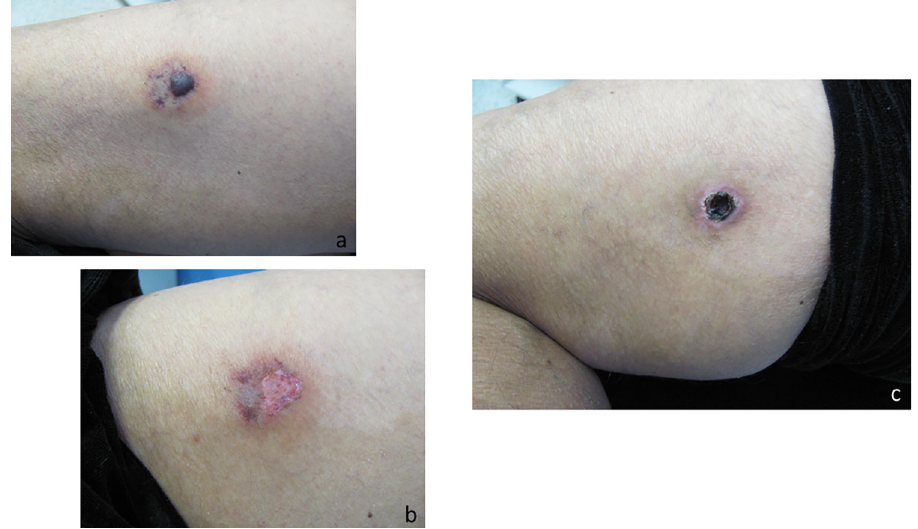
Fig 4. Evolution of a cutaneous lesion after a Loxosceles sp. bite. (a) marbled macula with blister, 7 days after the bite; (b) cutaneous lesion with a ruptured blister, 12 days after the bite; (c) eschar, 32 days after the bite.